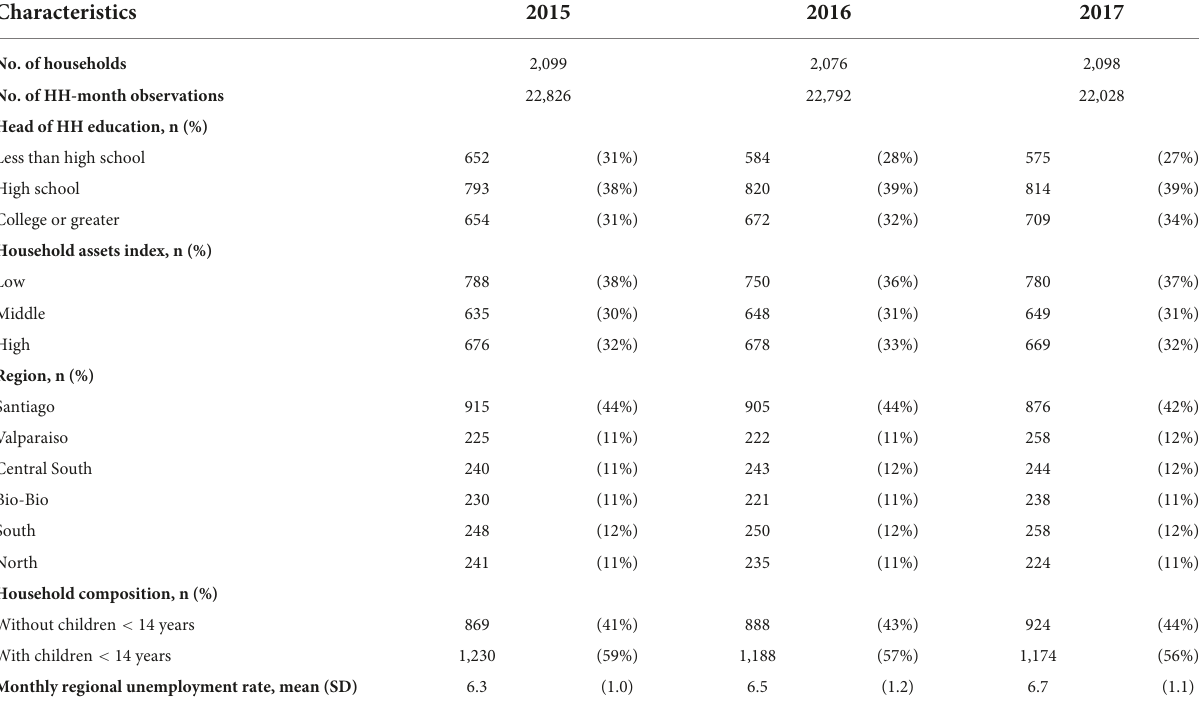
TABLE 2 Unweighted sociodemographic characteristics of the Kantar WorldPanel Chile analytic sample, from 2015 to 2017.